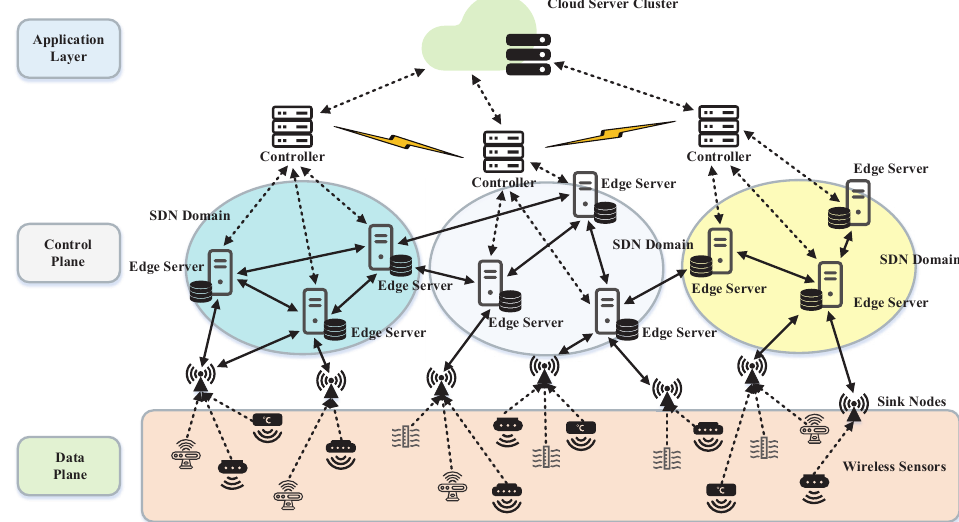
Figure 1. SDEC architecture. The SDEC architecture has three layers, converging the application, control and data layers of the software-defined architecture with the cloud, edge and end of the edge computing